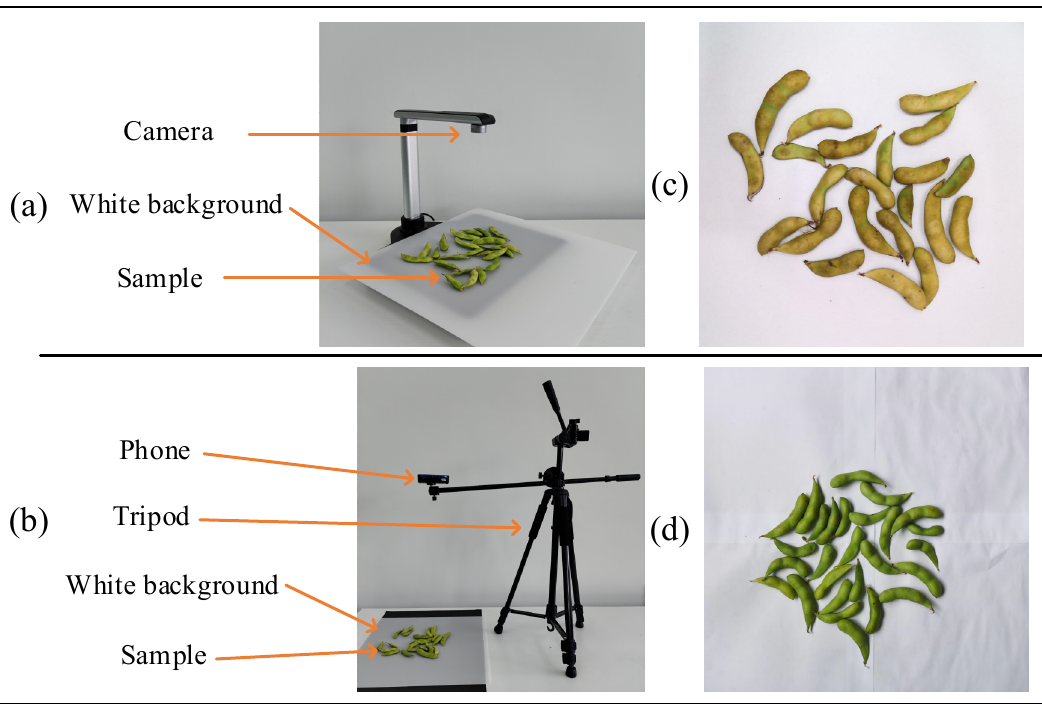
Figure 1. Image-acquisition platform and image-acquisition sample. ( a ) Scanner working diagram, ( b ) Mobile phone camera working diagram, ( c ) Sample image captured by scanner, ( d ) Sample image captured by mobile phone camera.